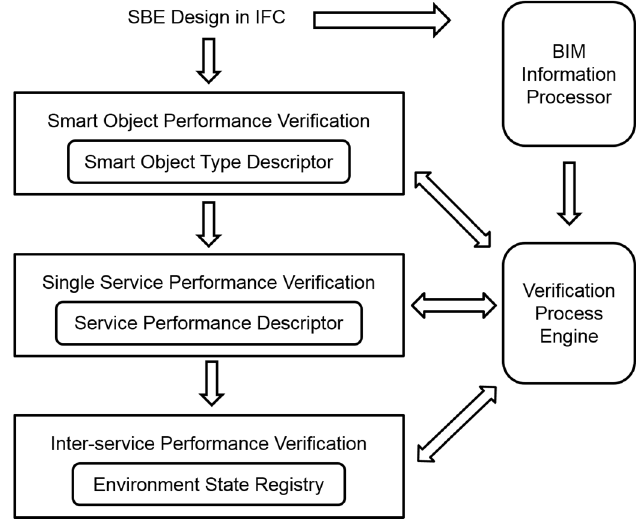
Figure 5. Design verification framework for smart built environments (SBEs) with